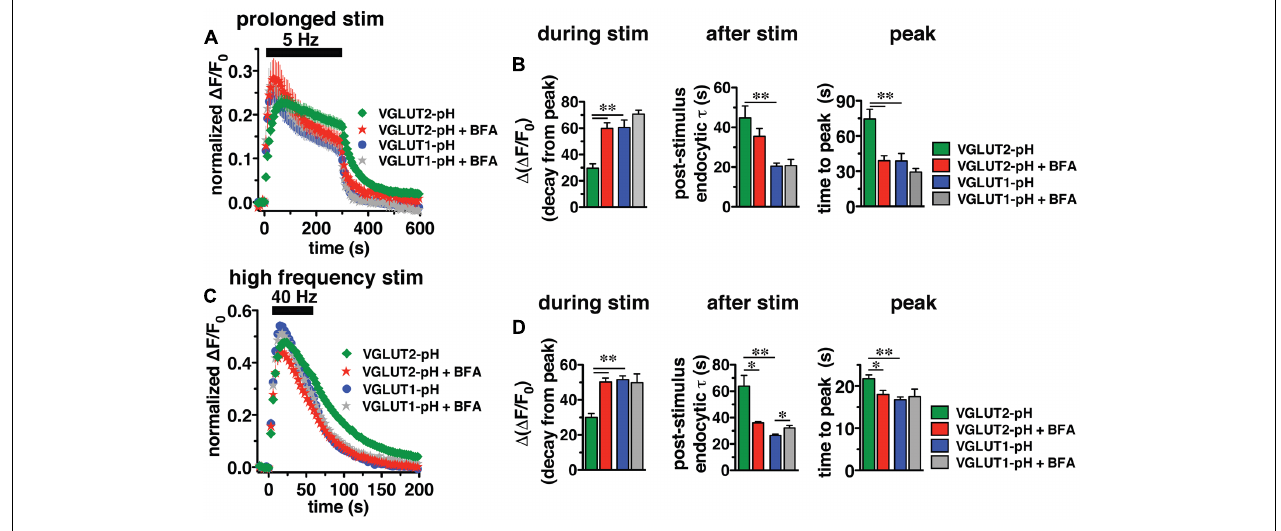
FIGURE 6 | Brefeldin A (BFA) selectively affects VGLUT2 recycling. (A) The time course of fluorescence changes of VGLUT1-pH (blue) and VGLUT2-pH (green) expressed in hippocampal neurons, acquired every 6 s, in response to prolonged stimulation at 5 Hz for 5 min are differently affected by BFA. (B) Left panel: In the presence of BFA (10 µ g/ml), VGLUT2-pH fluorescence changes are selectively accelerated. During stimulation, the extent of VGLUT2-pH fluorescence decay from the peak [ (cid:49) ( (cid:49) F/F 0 )] (green, 29.68 ± 3.25% from peak, n = 11) is less than VGLUT1-pH (blue, 60.59 ± 5.63% from peak, n = 13, ∗∗ p < 0.01). BFA treatment significantly increases the amount of VGLUT2-pH fluorescence decay from peak during stimulation (red, 59.84 ± 4.25% from peak, n = 10), without affecting the amount of VGLUT1-pH decay during stimulation (gray, 70.73 ± 2.89%, n = 8). Middle panel: VGLUT2-pH also exhibits a slower rate of post-stimulus endocytosis (green, τ = 44.76 ± 6.06 s) than VGLUT1-pH (blue, τ = 20.43 ± 1.63 s, ∗∗ p < 0.01) after prolonged stimulation. The post-stimulus rate of VGLUT2-pH endocytosis is faster in neurons treated with BFA (red, τ = 35.48 ± 3.97 s) than control (green) but is not statistically significant. BFA does not change the rate of VGLUT1-pH endocytosis (gray, τ = 20.75 ± 3.11 s). Right panel: While the peak fluorescence level is similar for the two VGLUT-pHs in response to prolonged stimulation, VGLUT2-pH fluorescence peaks more slowly (green, at 74.50 ± 8.27 s) than VGLUT1-pH (blue, at 38.77 ± 6.32 s, ∗∗ p < 0.01). In the presence of BFA, VGLUT2-pH fluorescence reaches peak value at 39.00 ± 4.22 s (red), similar to VGLUT1-pH. BFA treatment does not significantly alter the kinetics of VGLUT1-pH (time to peak 29.25 ± 3.09 s). (C) The kinetics of fluorescence change of VGLUT2-pH (green) in response to high frequency stimulation at 40 Hz for 60 s, acquired every 3 s, is different from that of VGLUT1-pH (blue). (D) Left panel: The VGLUT2-pH fluorescence decay from the peak [ (cid:49) ( (cid:49) F/F 0 ) , green, 30.08 ± 2.16% from peak, n = 12] during 40 Hz stimulation is significantly smaller than VGLUT1-pH (blue, 51.53 ± 2.24% from peak, n = 12). The decay of VGLUT2-pH during stimulation is significantly increased by BFA treatment (red, 50.30 ± 2.18% from peak, n = 8, ∗∗ p < 0.01), whereas that of VGLUT1-pH is not significantly affected by BFA (gray, 49.86 ± 4.96% from peak, n = 6). Middle panel: VGLUT2-pH exhibits a slower rate of post-stimulus endocytosis (green, τ = 63.81 ± 8.25 s) than VGLUT1-pH (blue, τ = 26.43 ± 1.06 s). BFA significantly accelerates the rate of VGLUT2-pH endocytosis after stimulation (red, τ = 35.99 ± 1.08 s), but slightly decreases that of VGLUT1-pH (gray, τ = 32.13 ± 2.04 s). Right panel: VGLUT2-pH fluorescence peaks more slowly (21.75 ± 0.91 s) than